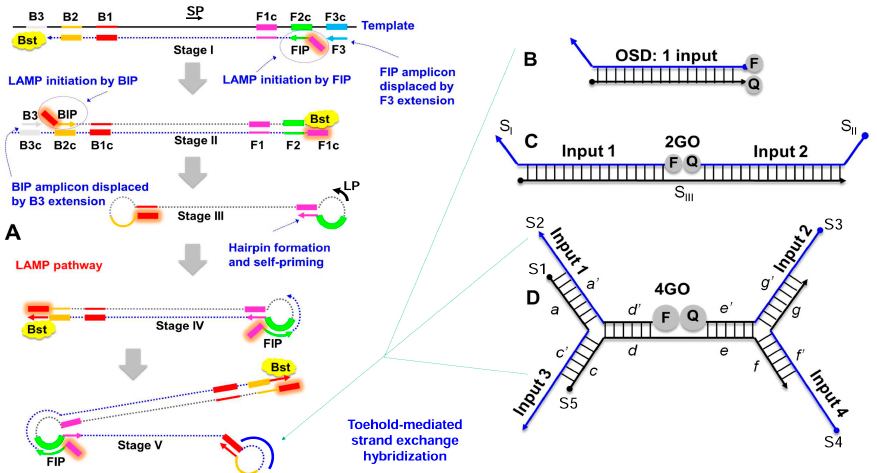
Figure 1. Schematic depicting ( A ) loop-mediated isothermal amplification (LAMP) integrated with ( B ) one-, ( C ) two-, or ( D ) four-input oligonucleotide strand exchange signal transducers. LAMP uses 2 inner (FIP and BIP) and 2 outer (F3 and B3) primers along with the optional stem (SP) and loop (LP) primers to prime strand displacement DNA amplification by Bst DNA polymerase. The resulting continuous amplification (initiated by both new primer-binding and by self-priming) generates double-stranded concatameric amplicons containing single-stranded loops to which non-priming oligonucleotide strand exchange signal transducers can hybridize. The one-input OSD signal transducer composed of one long and one short DNA strand can hybridize to a single LAMP amplicon loop sequence leading to separation of the fluorophore (F) and quencher (Q). The OR Boolean logic processing two-input strand exchange transducer, 2GO, is composed of two labeled strands, S I and S II , and a third bridging strand S III . Either S I and/or S II can hybridize to their specific LAMP loop sequences resulting in separation of F and Q. The four-input 4GO probe composed of 5 DNA strands (S1–S5) can hybridize to any combination of up to four different LAMP amplicon loops and perform an OR Boolean operation to produce fluorescence signal. The 4GO probe is denoted in terms of lettered domains ( a–g ), each of which represents a short fragment of DNA sequence in an otherwise continuous oligonucleotide strand. Complementarity is denoted by a single prime symbol.